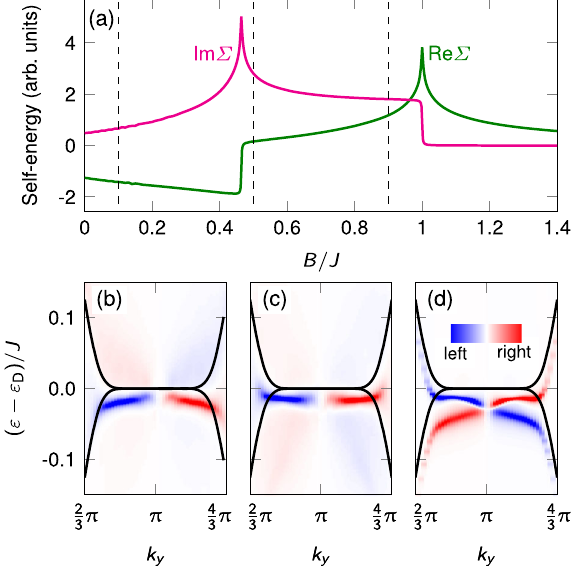
FIG. 10. Field-induced topological phase transition with damped chiral edge states for S ¼ 1 and D=J ¼ 0 . 15 . (a) Real and imaginary parts of the self-energy Σ − þ ð ε D Þ at the K 0 point K 0 as a function of the magnetic field B . At and Dirac energy ε D B ¼ B J , the Dirac cone leaves the two-magnon continuum, c ¼ and Im Σ − þ ð ε D Þ exhibits a step. At B 0 c ≈ 0 . 464 JS , there is a saddle K 0 point in the two-magnon continuum, associated with the Lifshitz transition in the decay contours shown in Fig. 9. This results in a logarithmic singularity of Im Σ − þ ð ε D Þ (labeled Im Σ for brevity), K 0 which is accompanied by a sign change of Re Σ − þ ð ε D Þ (labeled K 0 ε Þ of a honeycomb-lattice Re Σ ). (b) – (d) Position-resolved A k y ð slab (similar to that in Fig. 8) at field values indicated by dashed lines in panel (a). Blue (red) color indicates localization at the left (right) edge. Black lines indicate the flat harmonic edge state connecting the edge projections of the Dirac cones for zigzag